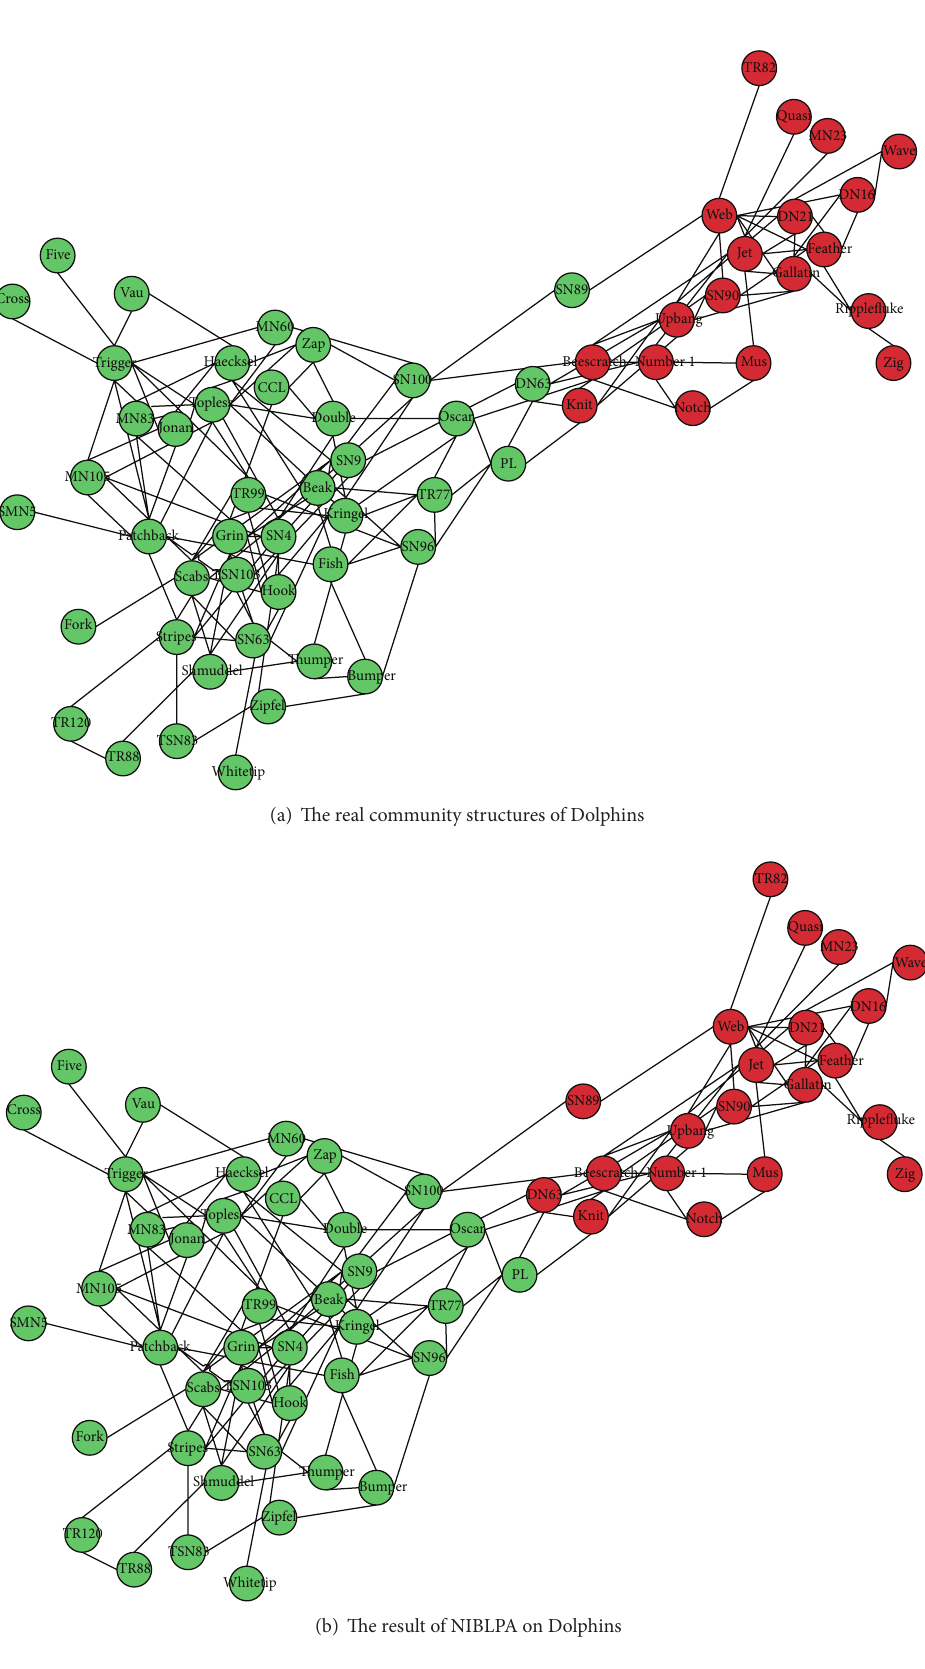
Figure 8: The community structures of